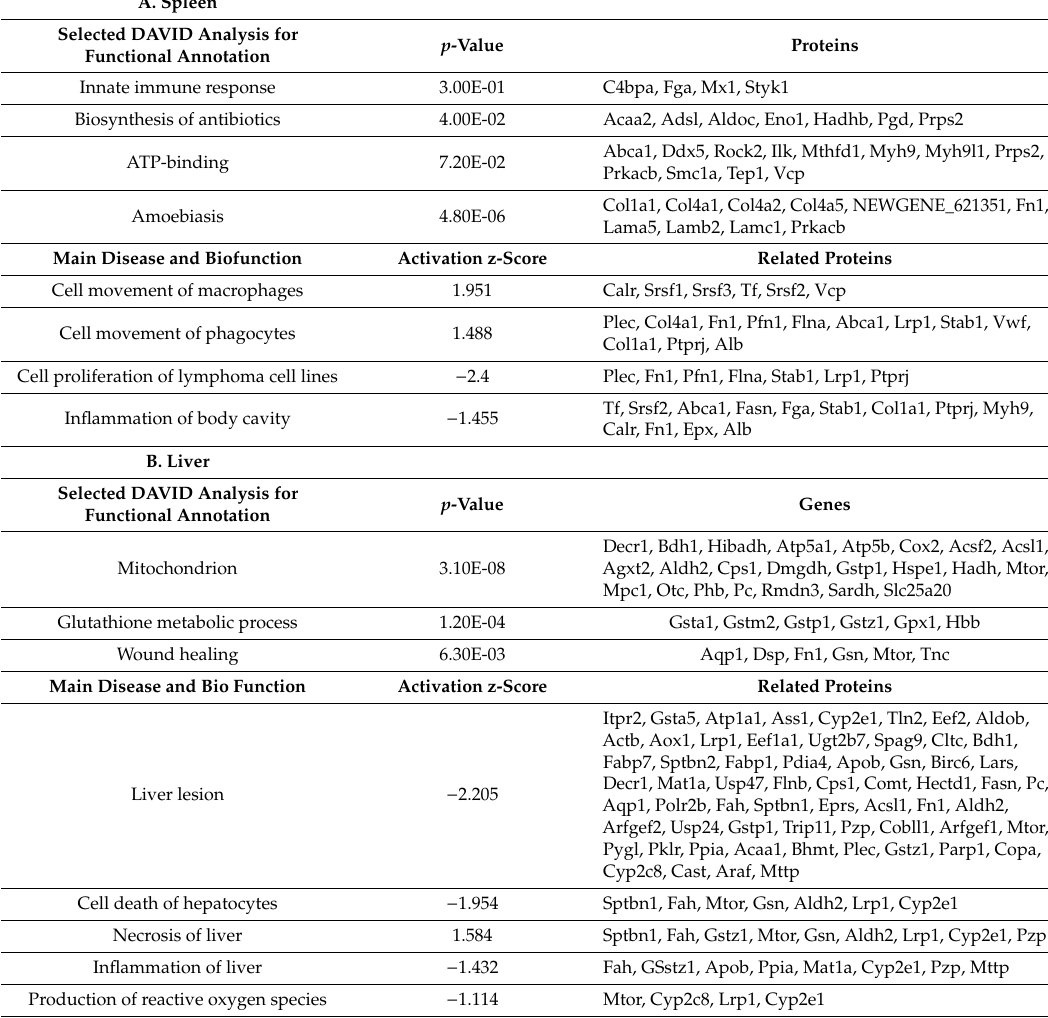
Table 4. Selected Database for Annotation, Visualization, and Integrated Discovery (DAVID) and IPA functional analysis of the identified proteins in the spleen and liver of the aged rat treated with NFP. A.